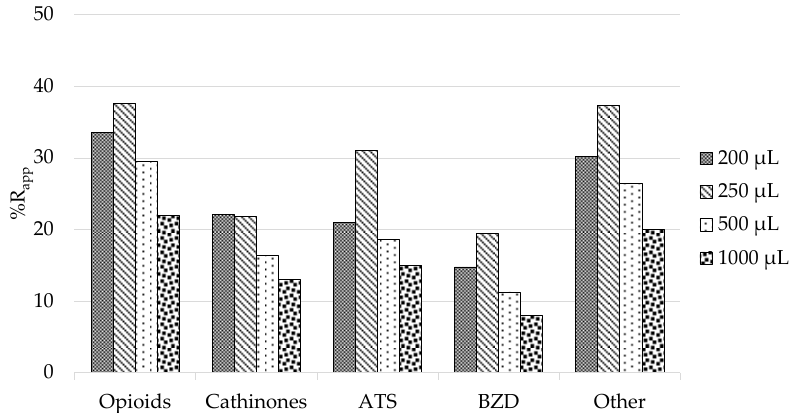
Figure 3. Evaluation of different loading volumes of urine:H 2 O at pH 4 (50:50, v/v ) at a spiked concentration of 50 ng mL − 1 .